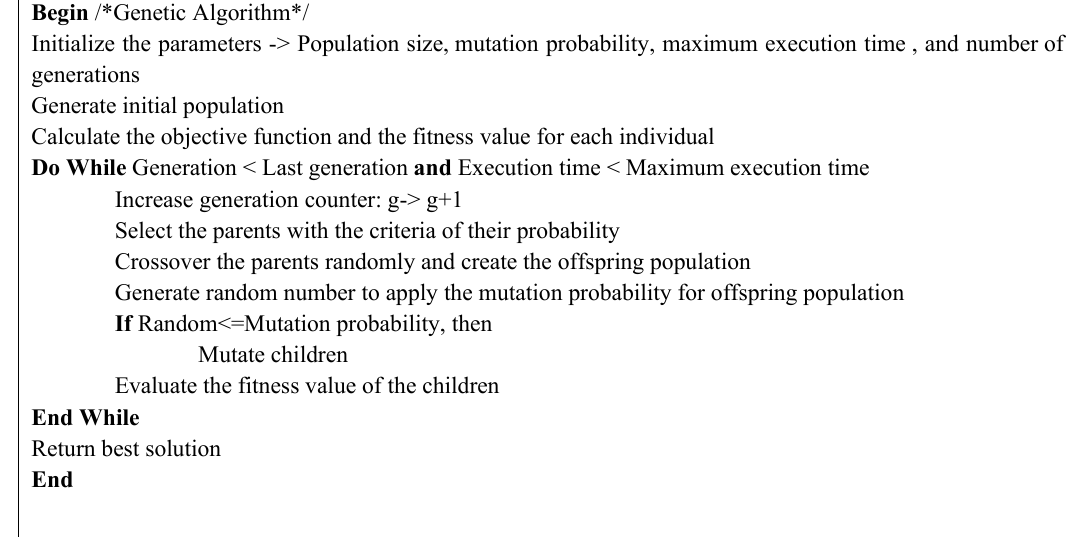
Pseudocode 1. Genetic Algorithm for the NWFSP